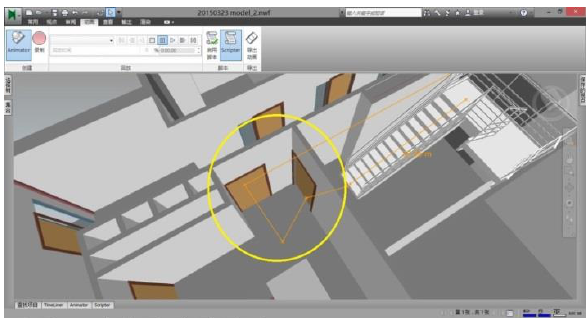
Figure 7. An example of the evacuation route in